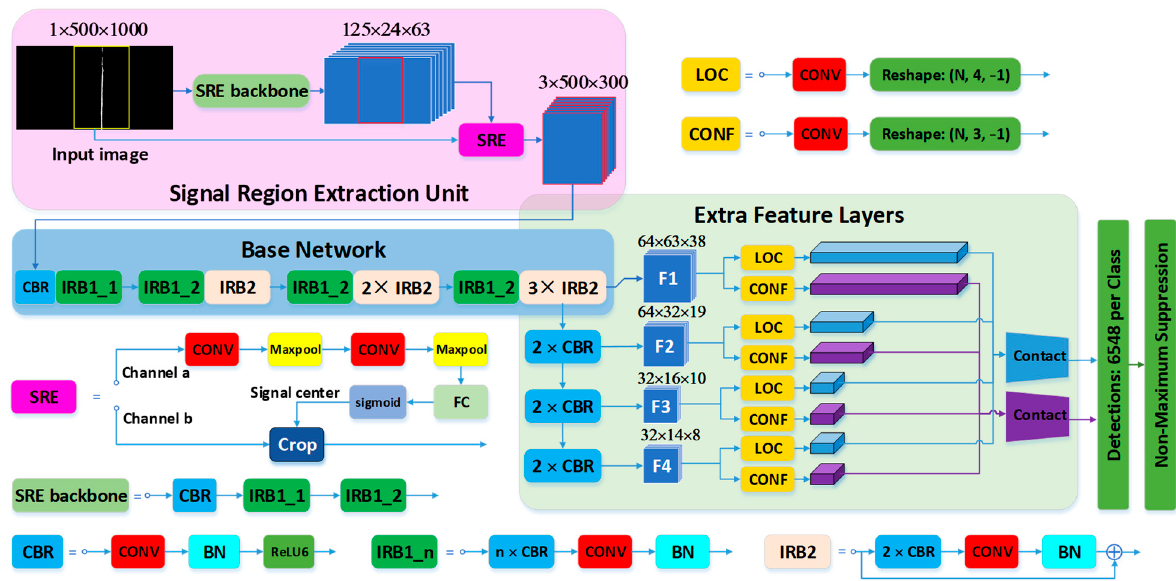
Figure 6. Autofocus SSD network architecture. ‘CONV’, ‘Maxpool’, ‘FC’, and ‘BN’ denote convolutional layer, maximum pooling layer, fully connected layer, and batch normalization layer, respectively. F1 to F4 represent feature maps. ‘LOC’ and ‘CONF’ denote the location and confidence prediction modules of the model, respectively. ‘SRE’ is the signal region extractor and ‘SRE backbone’ is the feature extraction network, and these two modules constitute the signal region extraction unit proposed in this paper.